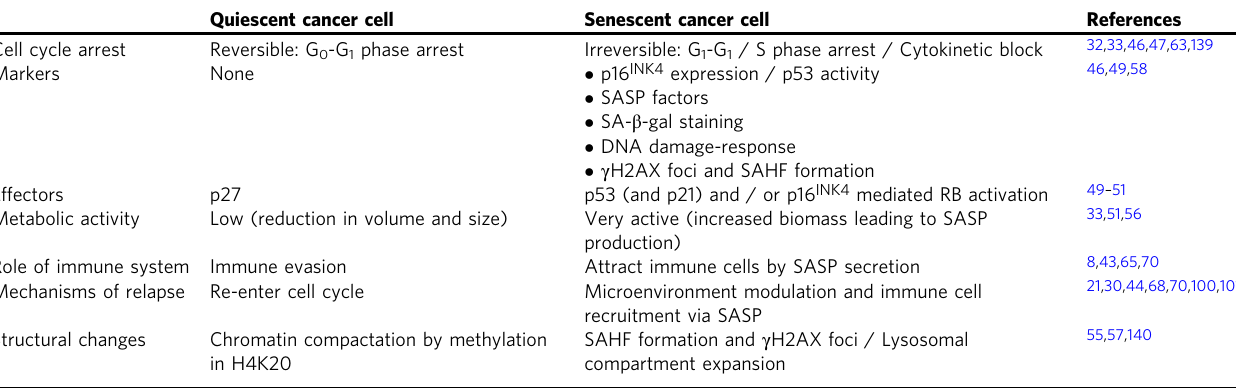
RB retinoblastoma protein, SA- β -gal senescence-associated β -galactosidase, SAHF senescence-associated heterochromatic foci, SASP senescence-associated secretory